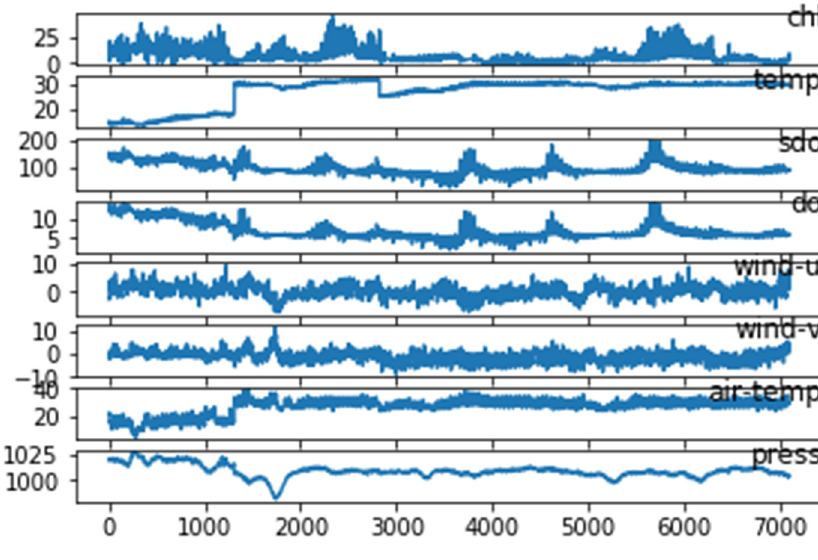
Figure 2. The trend of related factors. Table 1. Details of the dataset.